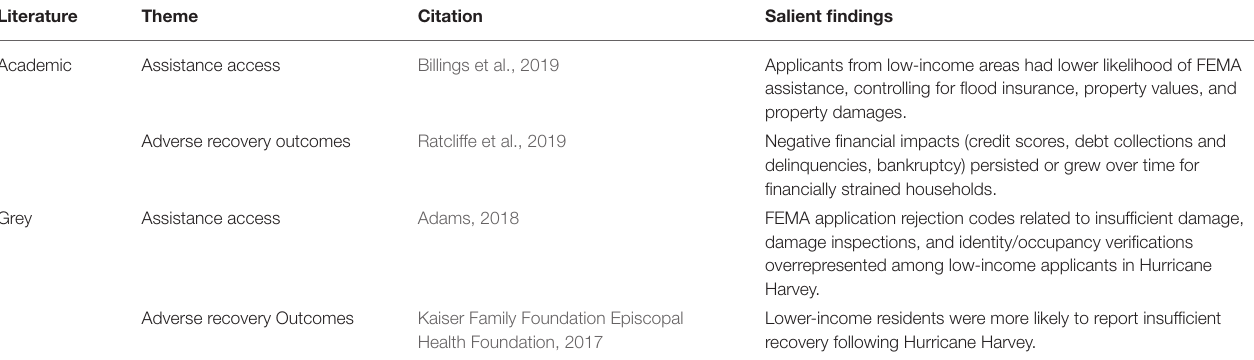
TABLE 3 | Key flood recovery studies focused on income, wealth, and financial